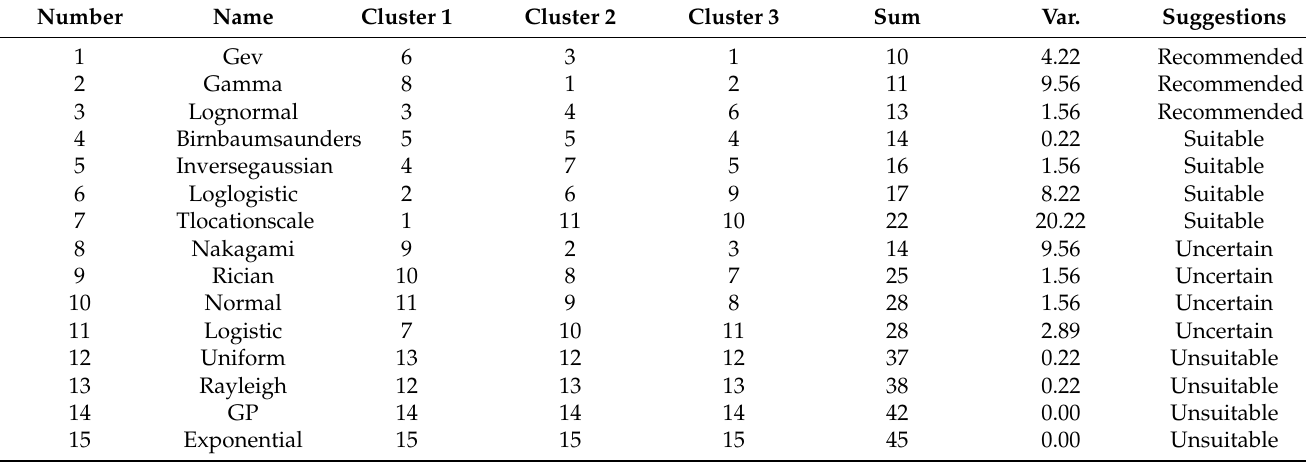
Table 3. Goodness-of-Fit Rankings of 15 Distribution Models for the Three